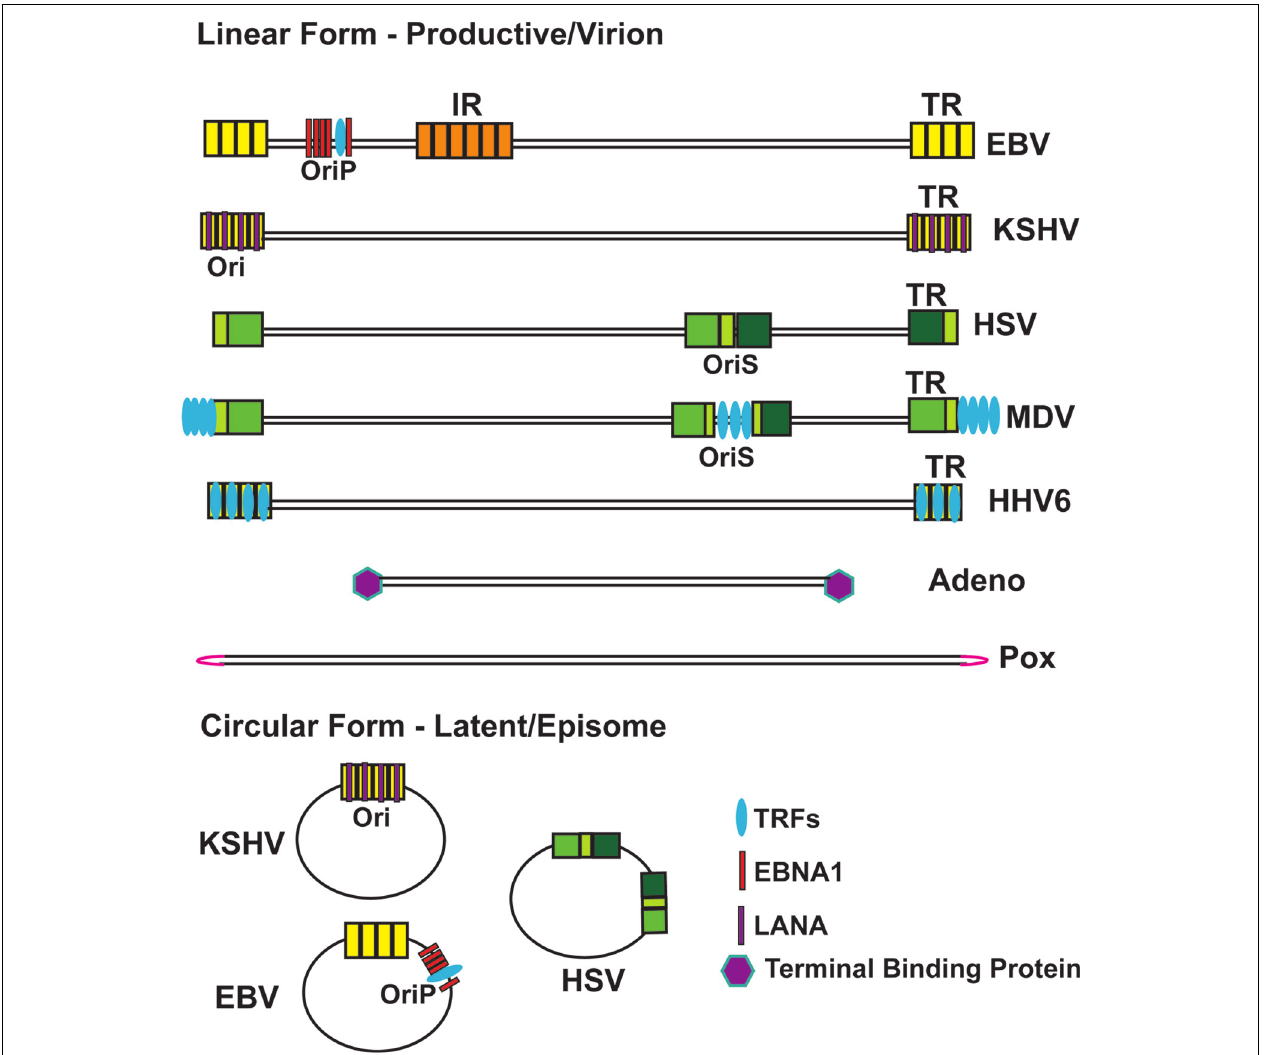
KSHV, respectively. EBNA1 binds to both FR and DS region of EBV OriP.TRFs bind to DS region of EBV OriP and MDV OriS, andTRFs-binding sites are indicated forTR of MDV and HHV6.The terminal hairpin structure for Pox virus is indicated in